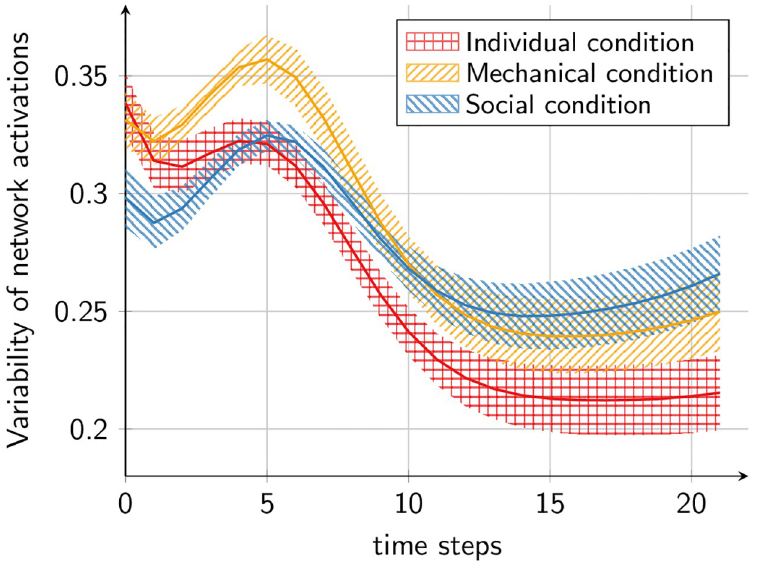
Fig 9. Mean and standard error across networks of the average pairwise distances between the neural activation traces of the three different conditions (cf. Fig 8). Activations were normalized to [0, 1] independently for each network